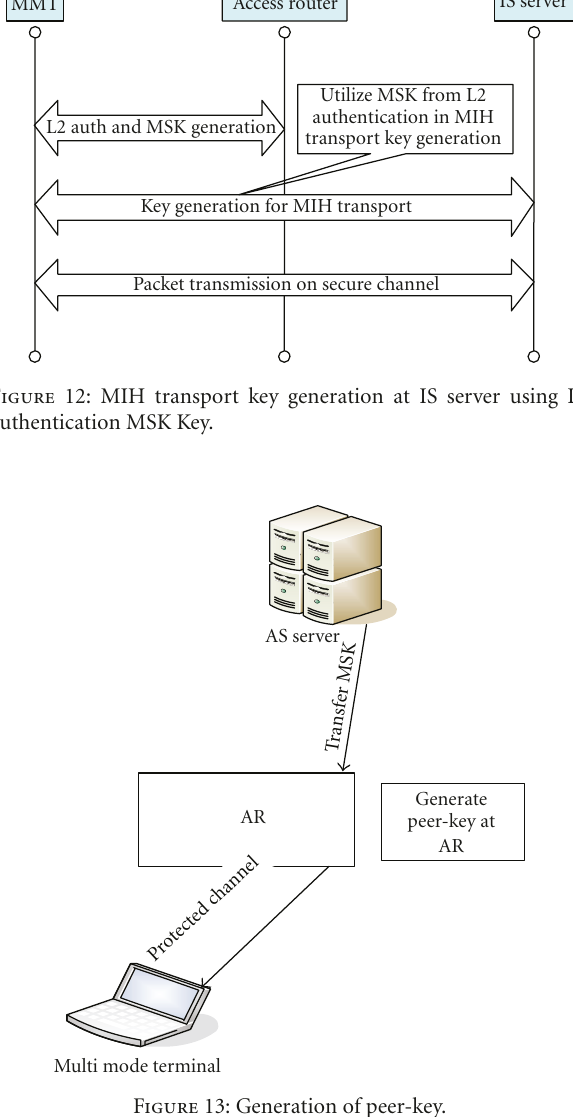
Figure 13: Generation of